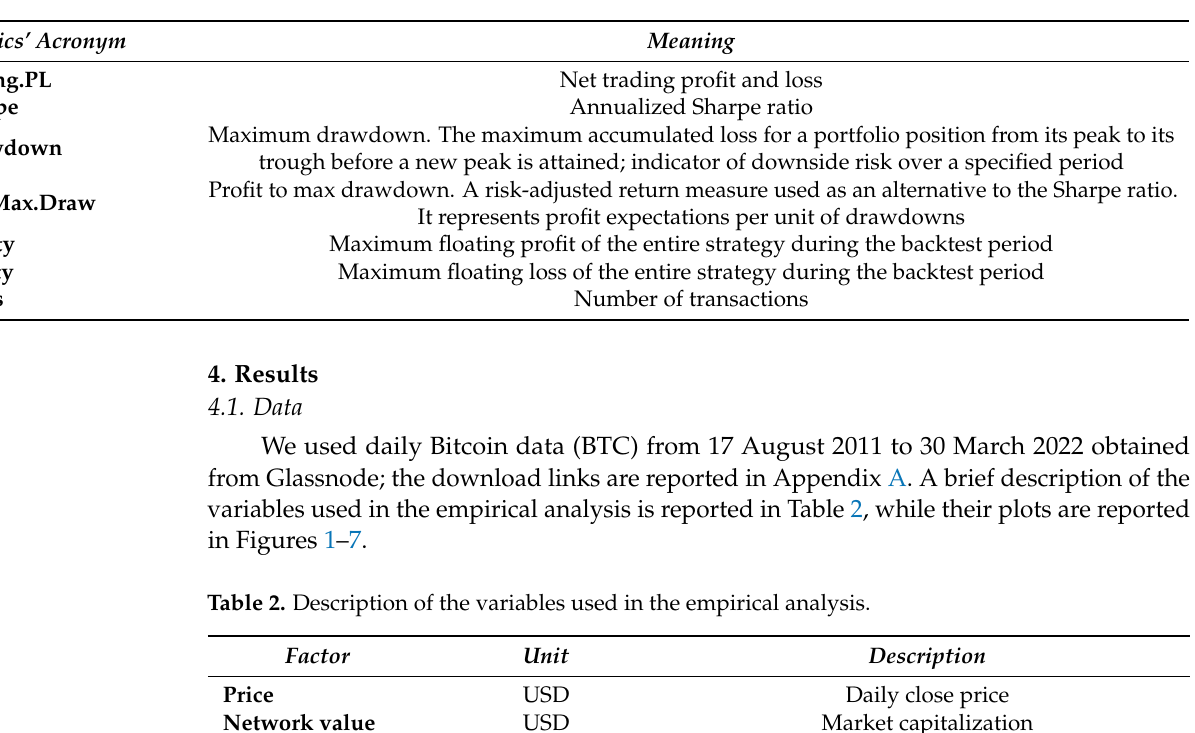
Table 1. Evaluation metric acronyms and meanings.